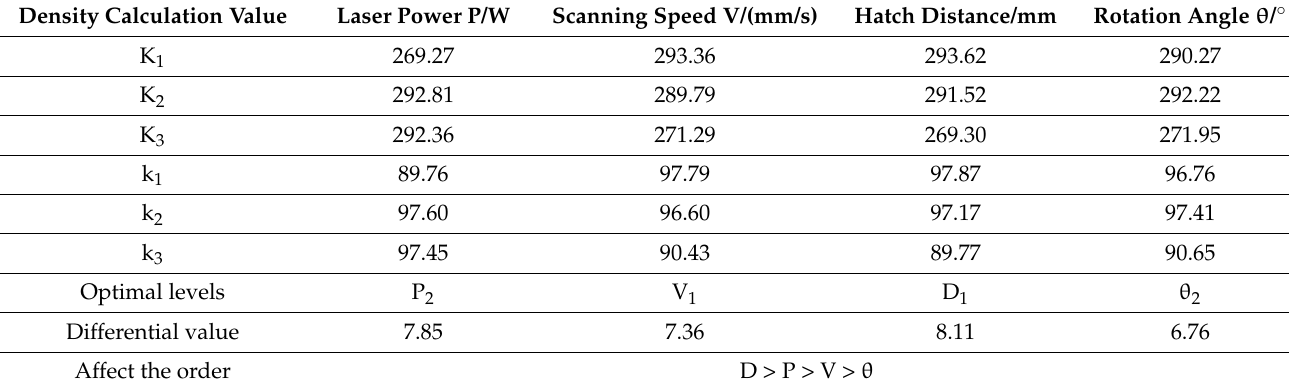
Table 5. Effect of process parameters on relative density using Archimedes